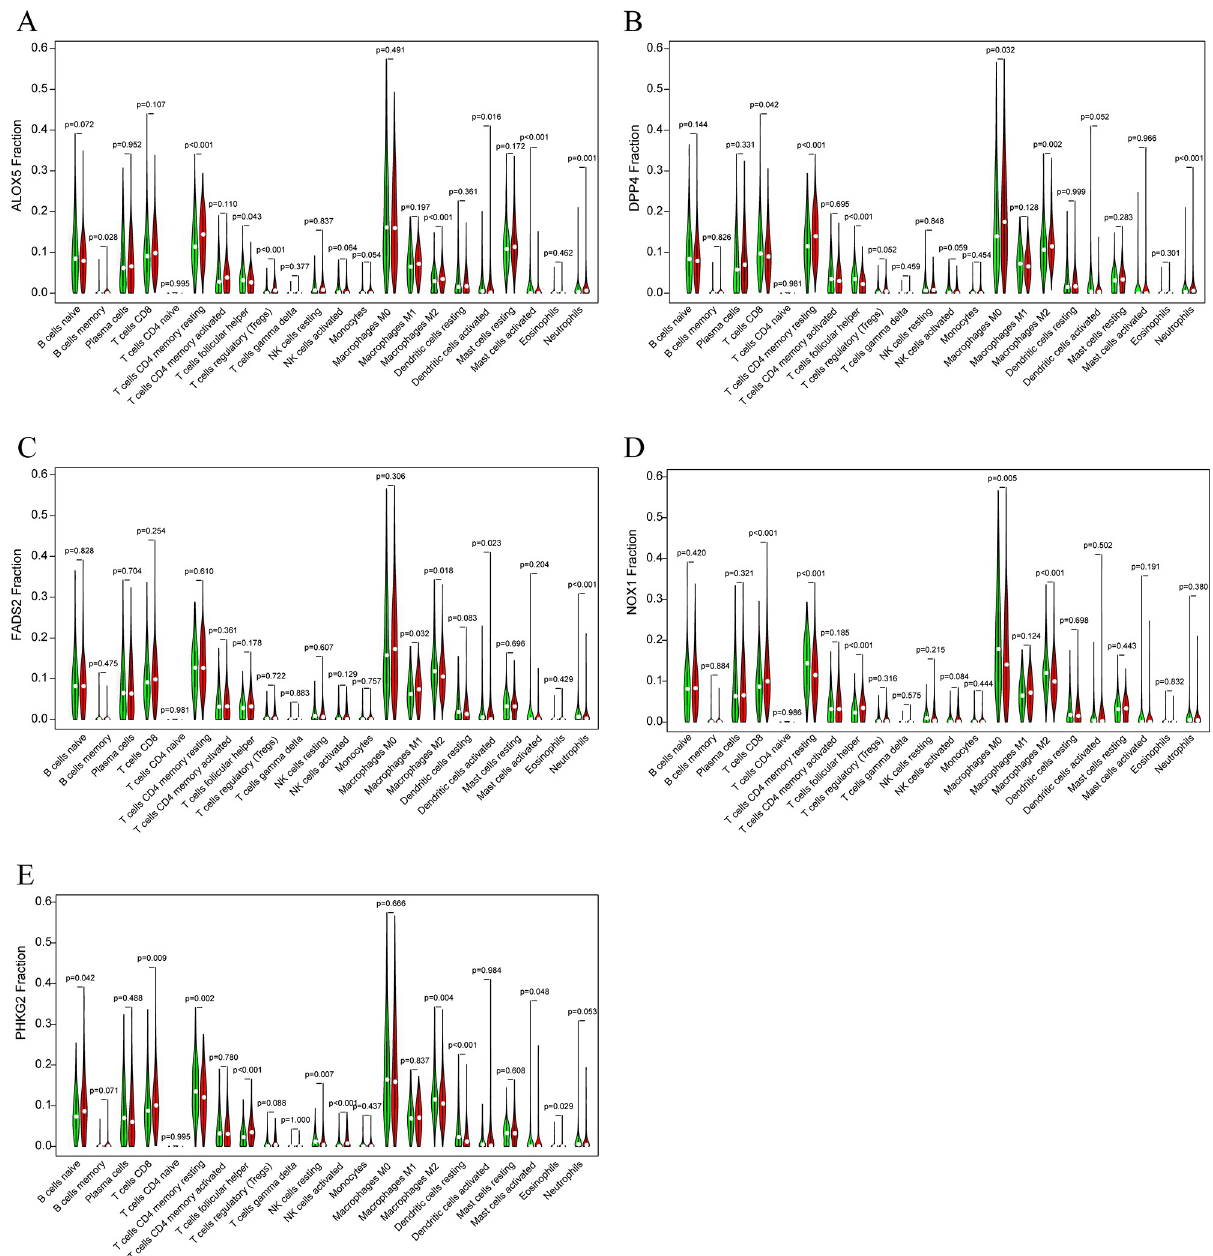
Fig 10. Violin plot showed the proportions of 22 immune cells between high risk and low risk with the 5 genes.